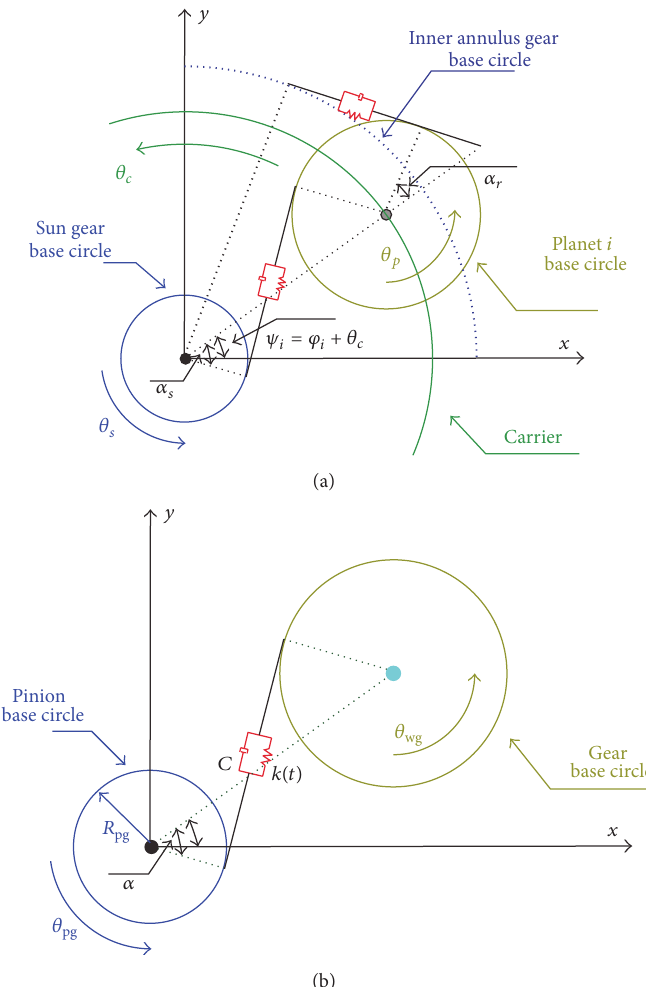
Figure 7: Two-dimensional lumped parameter model of a planetary gearbox: (a) the planetary gear-set and (b) the fixed-axis gear stage.